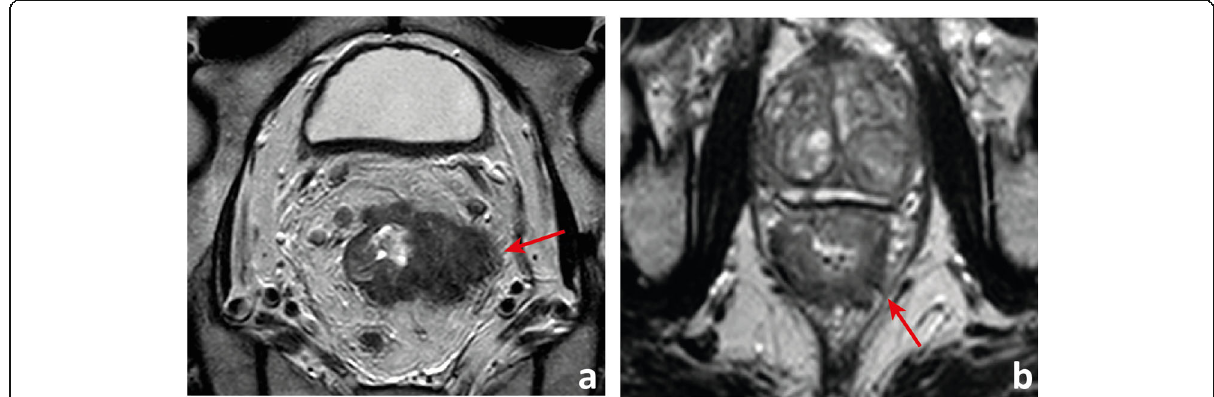
Fig. 13 Circumferential margin of resection involvement. a A T3d tumour invades the mesorectal fascia on the left side (arrow). b A 1 – 2 mm fat plane between this mrT3b low rectal cancer and the sphincter complex (arrow) is observed and as such the circumferential margin of resection may be considered free